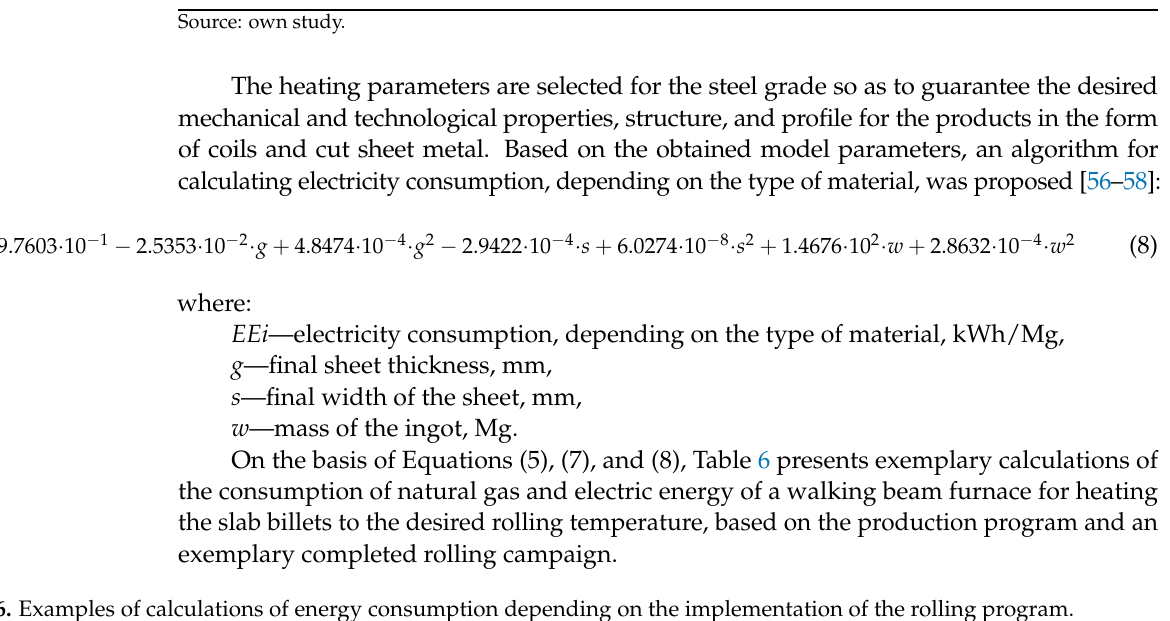
Table 6. Examples of calculations of energy consumption depending on the implementation of the rolling program. b >